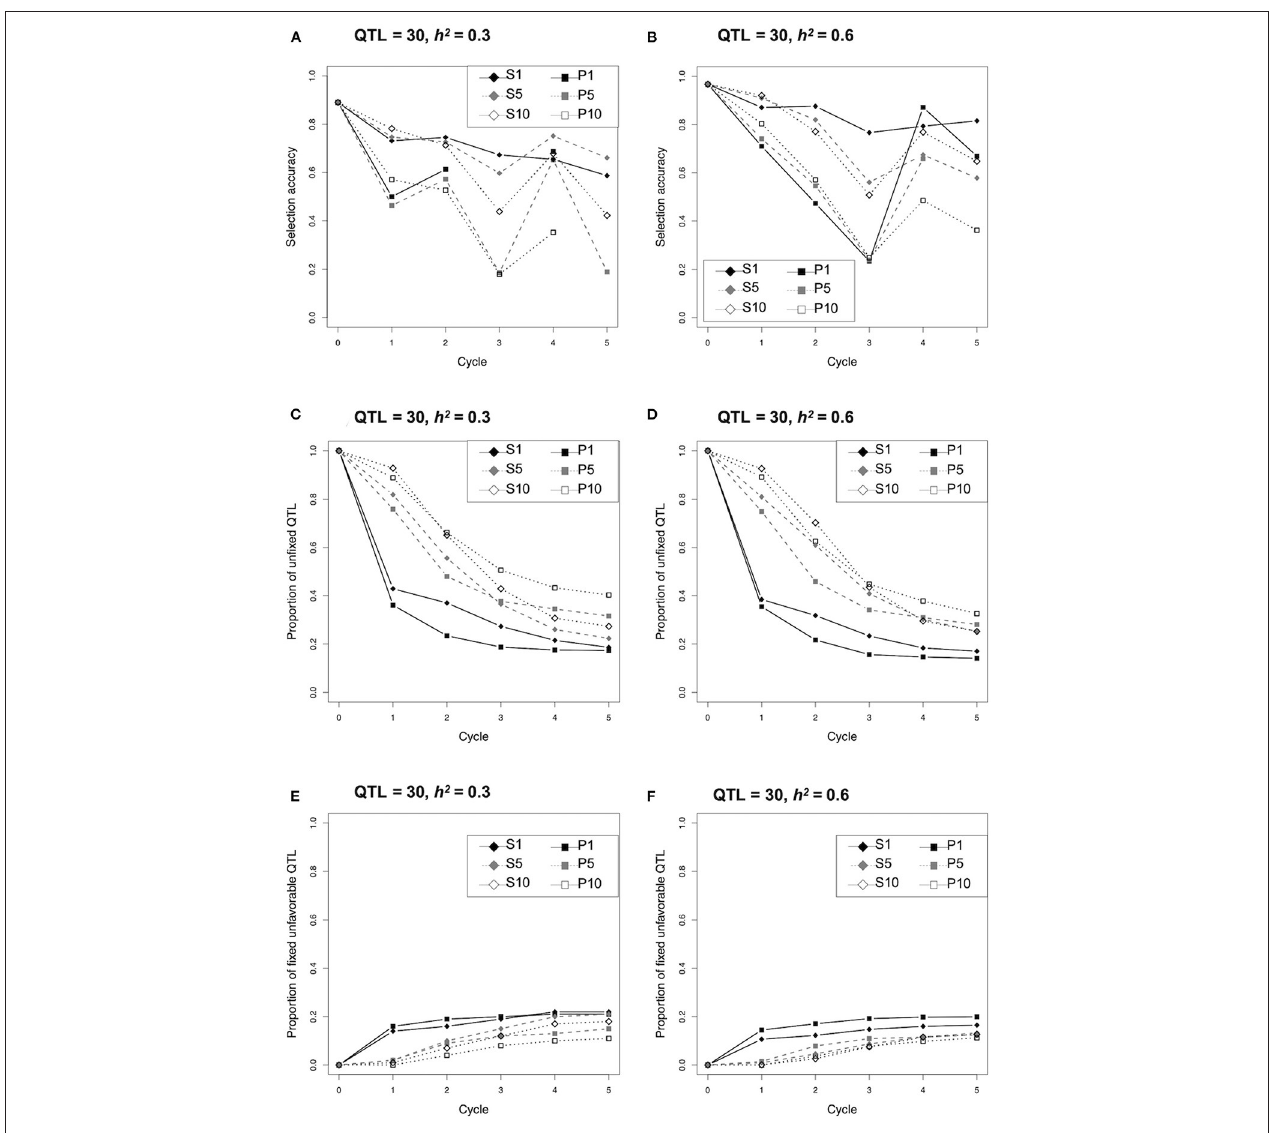
FIGURE 3 | Comparison of selection accuracy, proportion of unfixed quantitative trait loci (QTLs), and fixed unfavorable QTLs during selection cycle of the different selection strategies under the condition of 30 QTLs and h 2 = 0.3 or